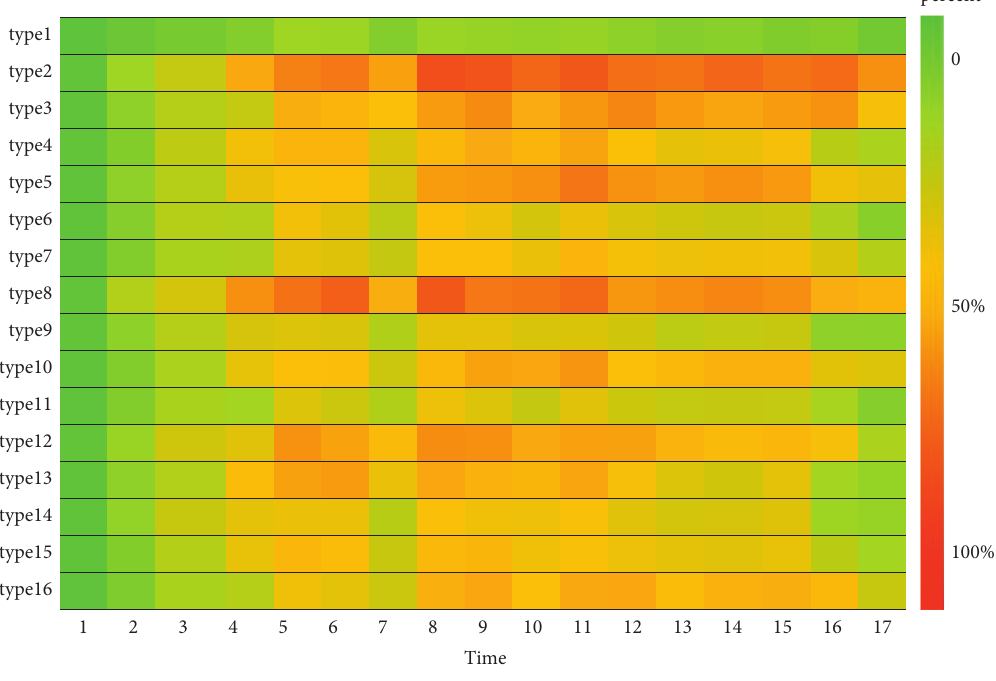
Figure 3: Passenger flow pattern thermodynamic diagram.